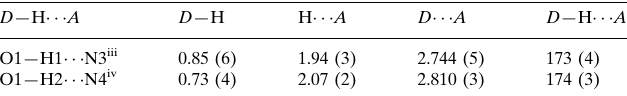
Hydrogen-bond geometry (A˚ , (cid:2)